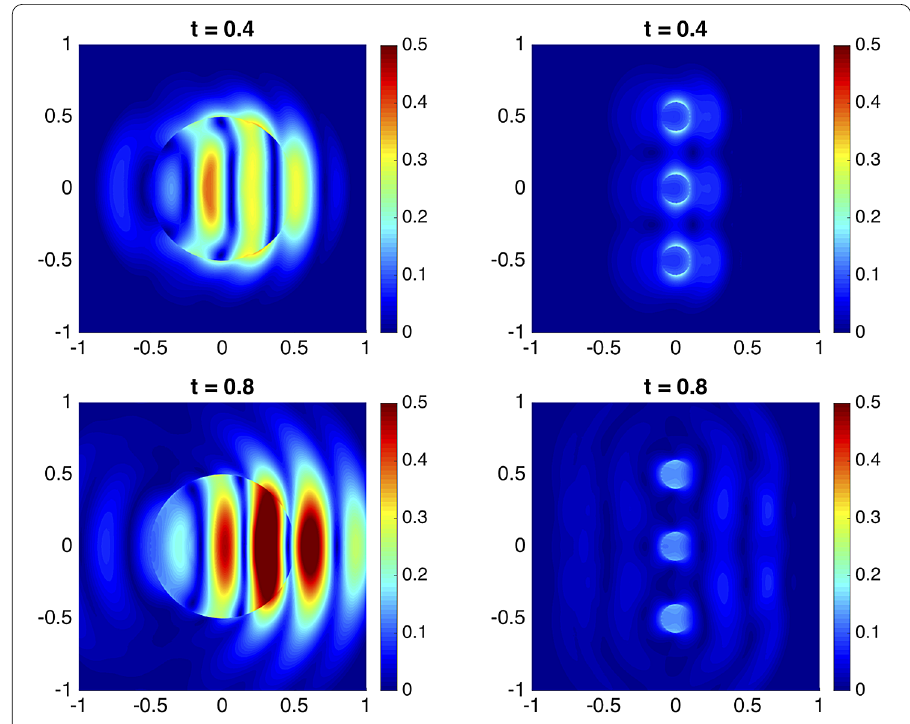
Figure 6 Evolution of the scattered field intensity (21) with time: one circle (left); three circles (right)